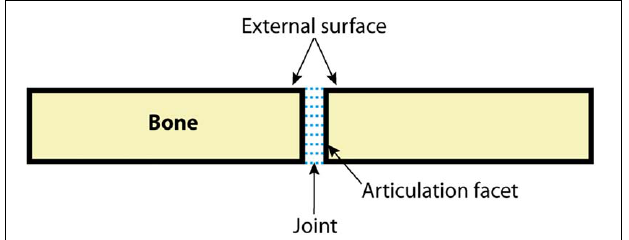
FIGURE 2 | Simplified cross section of a skull suture, illustrating the terminology used in this manuscript.